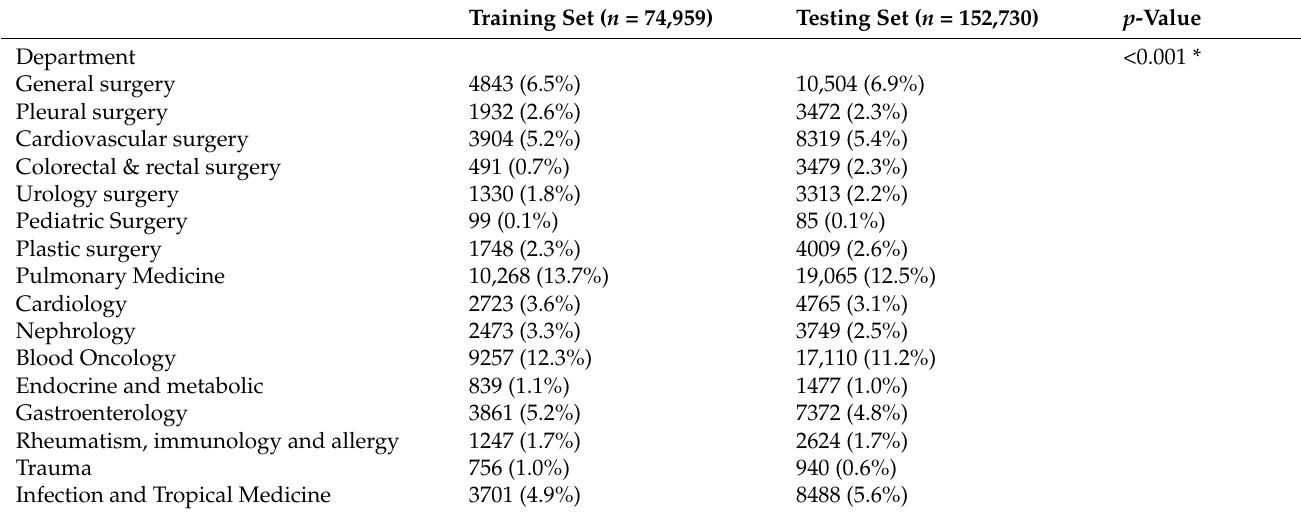
Table 1. Medical records distribution and scoring in the training set and testing set of different departments.